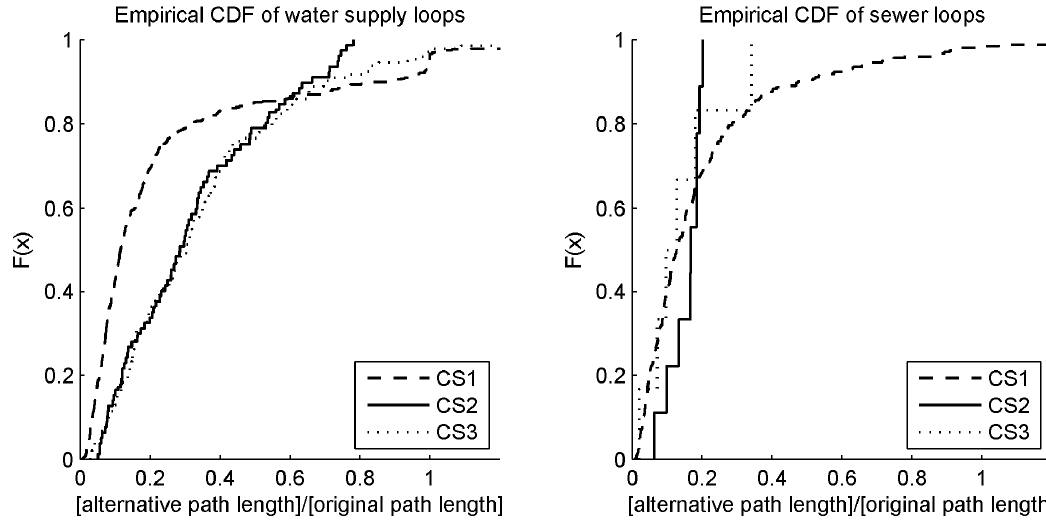
Figure 8. CDF plots of CIs of water supply and sewer networks.